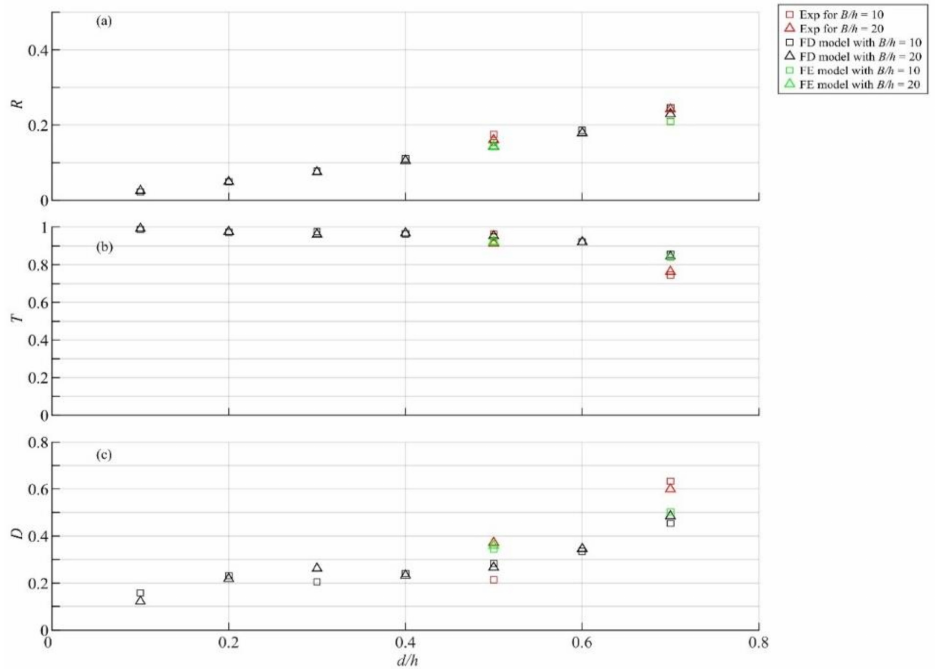
Figure 6. Relation of ( a ) reflection ( b ) transmission and ( c ) dissipation coefficient with step height for the solitary wave over a submerged step with step widths B/h = 10 and 20 (red squares denote experimental results with B/h = 10 and red triangles denote experimental results with B/h = 20; black squares denote FD model results with B/h = 10 and black triangles denote FD model results with B/h = 20; green squares denote FE model results with B/h = 10 and green triangles denote FE model results with B/h = 20,